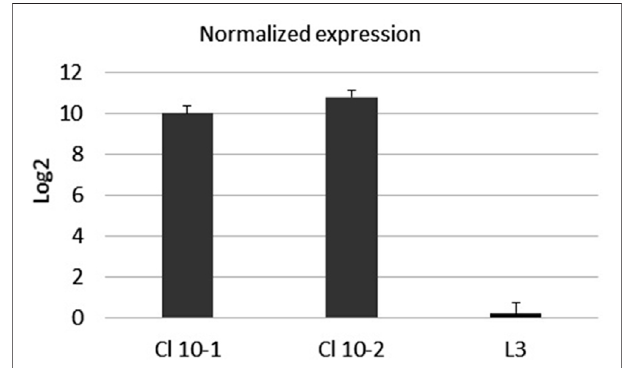
FIGURE5 | ThemRNA expression level ofSarsS-protein gene fragment in the culture of E. faecium L3. Data were analyzed using the comparative threshold cycles ( ΔΔ Ct) method, normalized to D-alanine-D-alanine ligase gene of L3, and presented as the fold changes in gene expression of S-protein modi fi ed L3 relative to the pure L3. Black bars represent the averaged data obtained based on two L3-SARS cultures, the bar at the right represents the averaged data obtained with pure E. faecium L3. The average Ct values were 13.5 when RNA from modi fi ed L3-SARS or E. faecium L3 was ampli fi ed using primers to the D-alanine-D-alanine ligase as a housekeeping gene.Whenusingprimersspeci fi ctoS-protein,RNAisolatedfrommodi fi ed E. faecium L3culturesgaveaverageCtvaluesof28.5,andforpure E.faecium L3 average Ct values were more than 40 which indicated the absence of ampli fi cation.